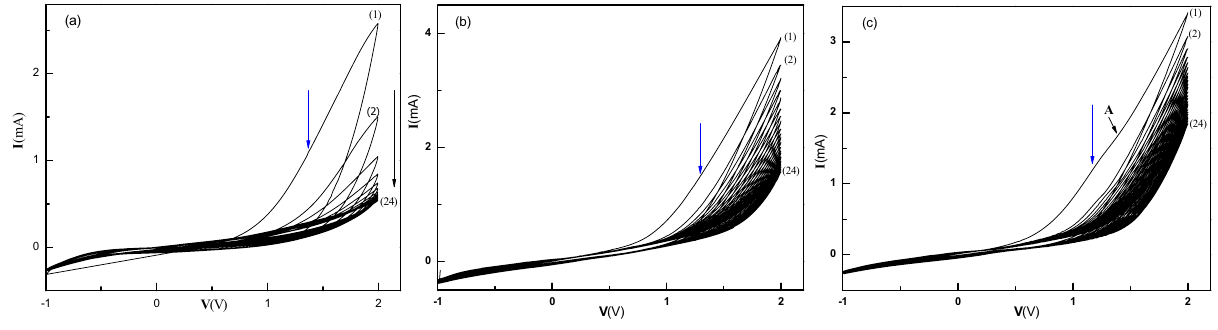
Figure 3: VCs of thiophene on oxide PSi surface at scan rates of ( a ) 20 mV · s − 1 , ( b ) 200 mV · s − 1 , and ( c ) 400 mV · s − 1 .